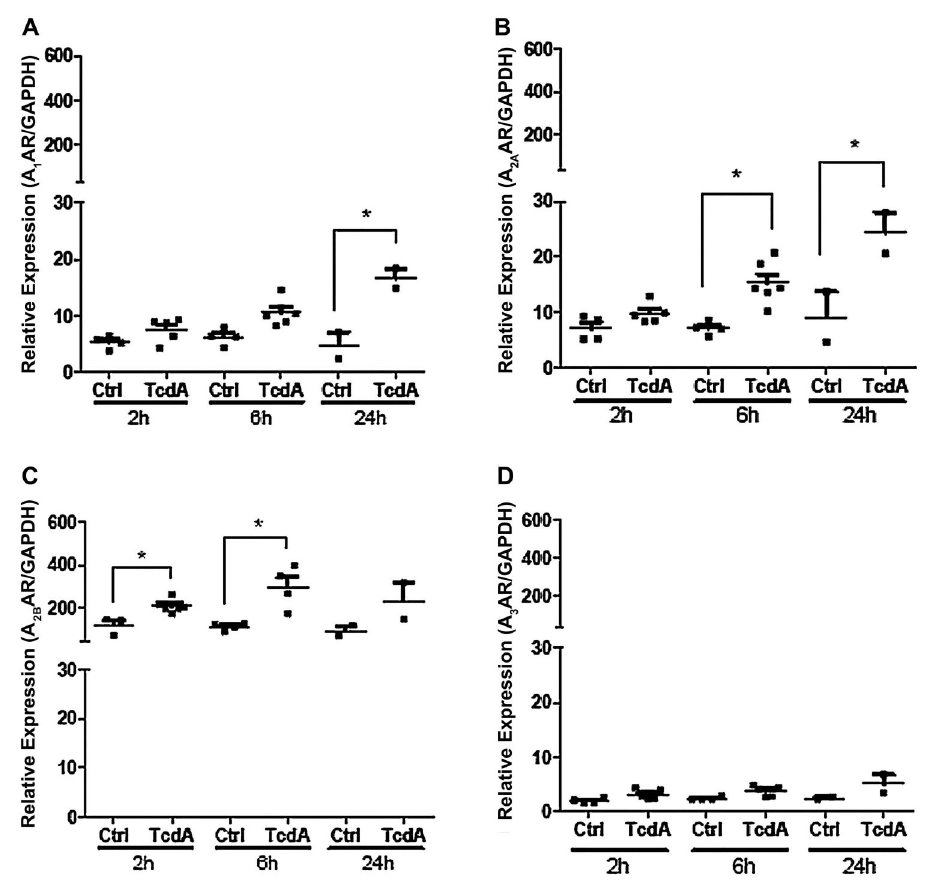
Figure 4 . Effects of C. dif fi cile TcdA on the adenosine receptors (AR) gene expression in cecal epithelial cells. The murine cecum (n=6/ group) was injected with TcdA (20 m g/loop) and incubated for 2, 6, and 24 h. The cecal epithelial cells were isolated and mRNA was extracted for A 1 AR ( A ), A 2A AR ( B ), A 2B AR ( C ), andA 3 AR ( D ) analysis by qPCR. *P o 0.05 compared with control (Ctrl) (one-way ANOVA with Bonferroni post-test). Vertical lines indicate mean ±